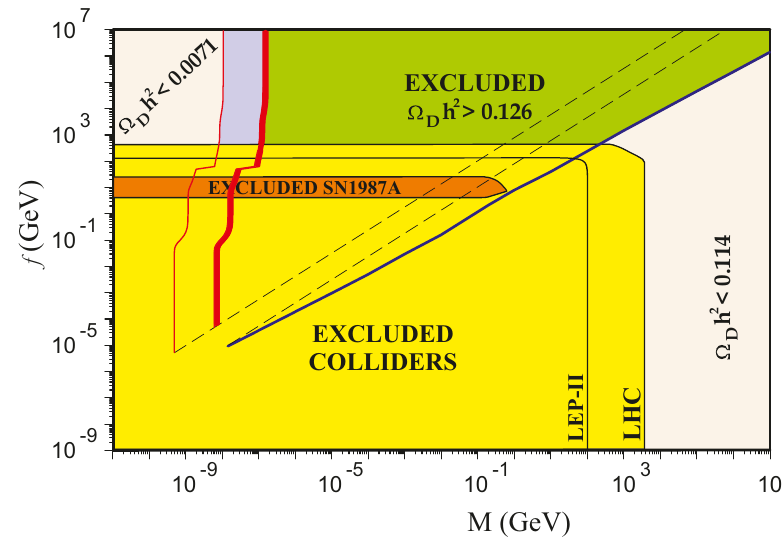
Figure 1 . In this (cid:12)gure we show the combined exclusion plot for a model with a single disformal scalar described by the branon Lagrangian. M is the scalar (branon) mass, whereas f is the brane tension scale (which veri(cid:12)es 2 f 4 = M 4 ). Within the (green) upper area, the model is sd ruled out because these scalars are overproduced, The (purple) left region is excluded by structure formation, whereas the (yellow) lower regions are excluded by LEP-II and LHC single photon analysis. Supernovae cooling rules out the horizontal (orange) area. The (blue) solid line on the right is associated with a cold DM behaviour with the proper relic density. The two (red) solid lines on the left are related to a hot DM behaviour. This (cid:12)gure is taking from ref. [38], where a more detailed explanation can be